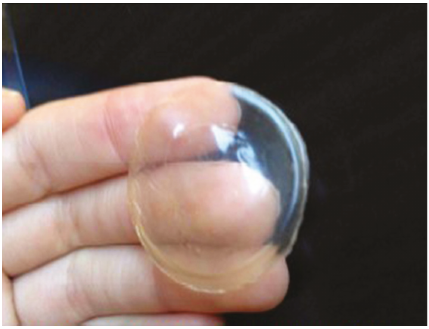
Figure 1: Latex biomembrane. This fi gure is reproduced from Ribeiro et al. [13], public